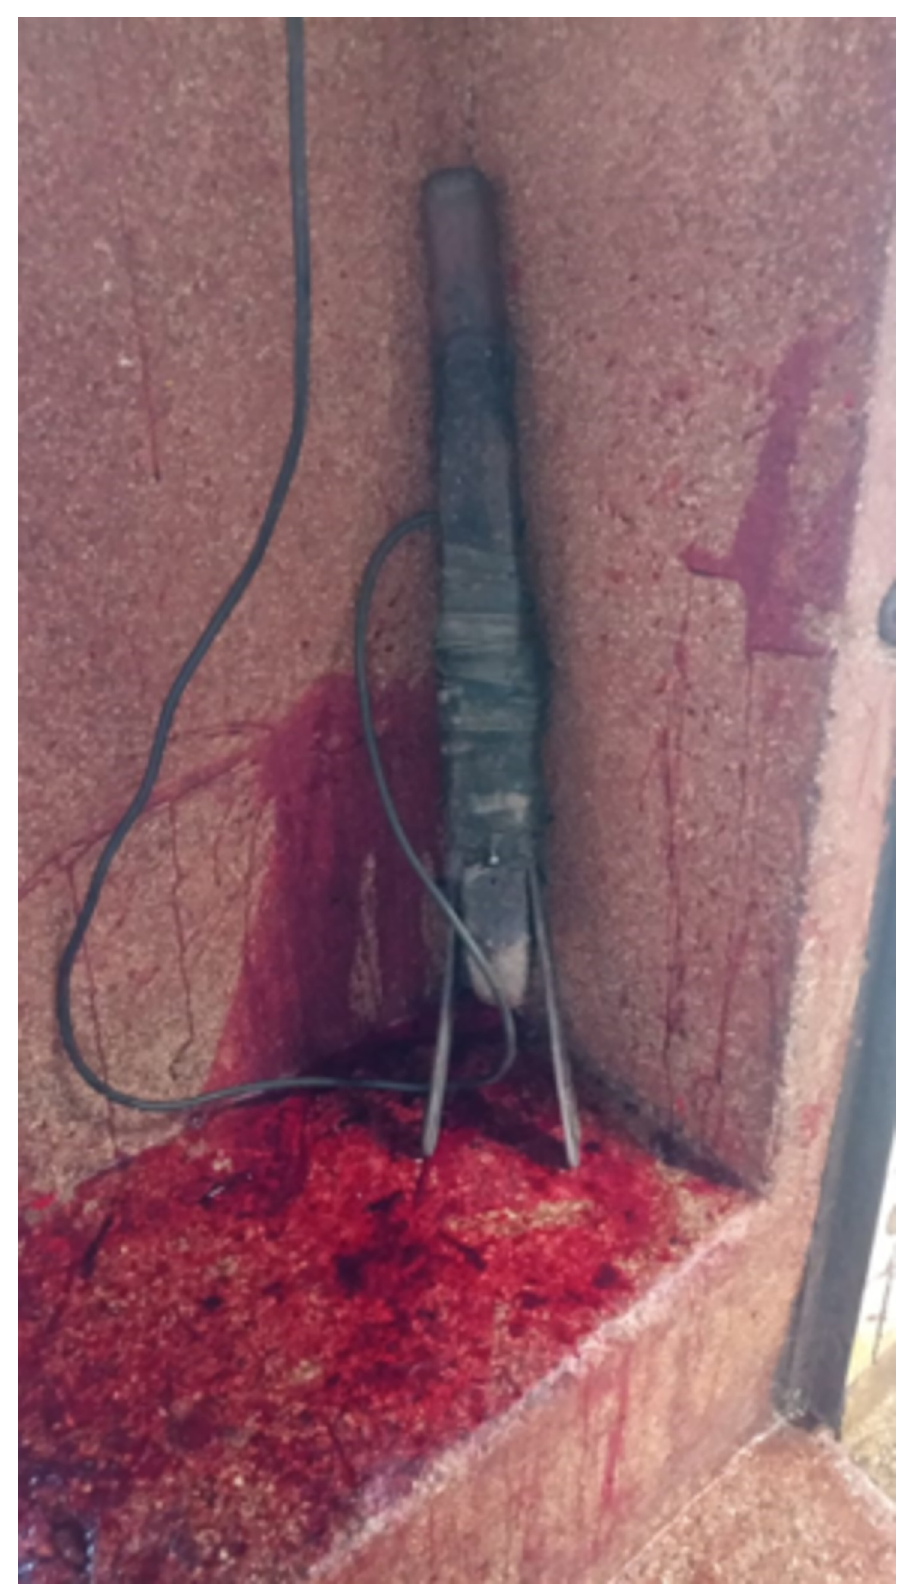
Fig 4. An image showing the improvised stunning device used in the study abattoir. https://doi.org/10.1371/journal.pone.0272951.g004 PLOS ONE | https://doi.org/10.1371/journal.pone.0272951 August 26,